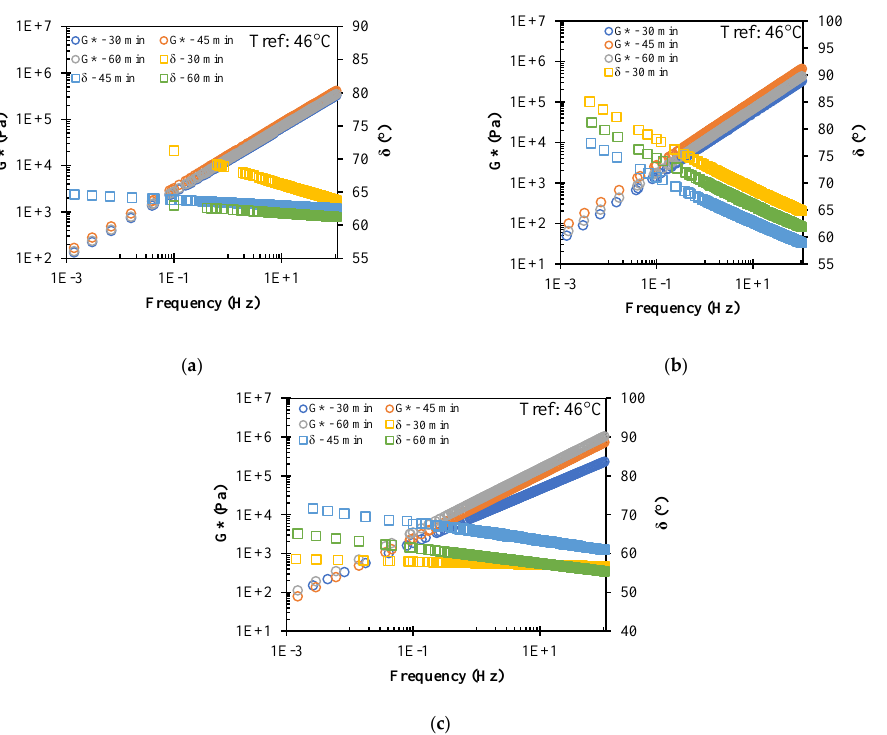
Figure 5. Master curve of G * and δ of different mixing times at 46 °C of: ( a ) 15% CR; ( b ) 18% CR; ( c ) 21% CR. Table 3. Optimum mixing time for different percentages of CR.